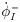
Rotational hopping model.Generalised coordinates q = [x, y, ϕ]T with x the horizontal displacement from origin O, y vertical displacement from origin O, angular position ϕ, and system parameters mass m, moment of inertia I, wheel radius R, eccentricity a, and obstacle height h. (I) State just before angular impulse. The angular velocity of the system is reverted in a collisional event with angular impulse ζR from ϕ˙I- to ϕ˙II. The velocity vCoM dictated by the rolling motion then leads to a ballistic flight phase. (II) Ballistic flight phase. (III) State just before impulsive energy loss due to impact ζ. Note that ϕ˙II=ϕ˙III-.